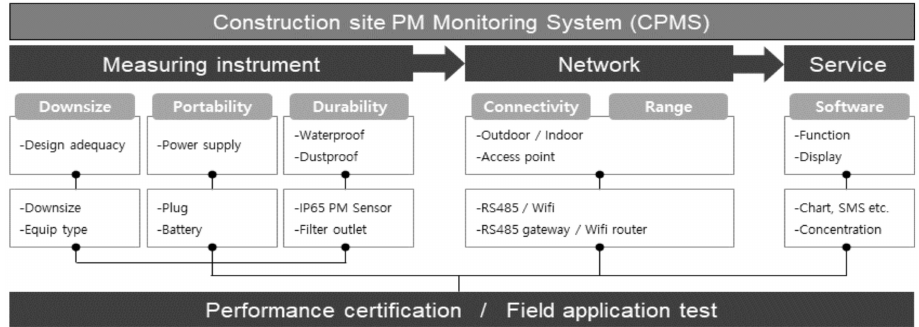
Figure 1. Framework of CPMS